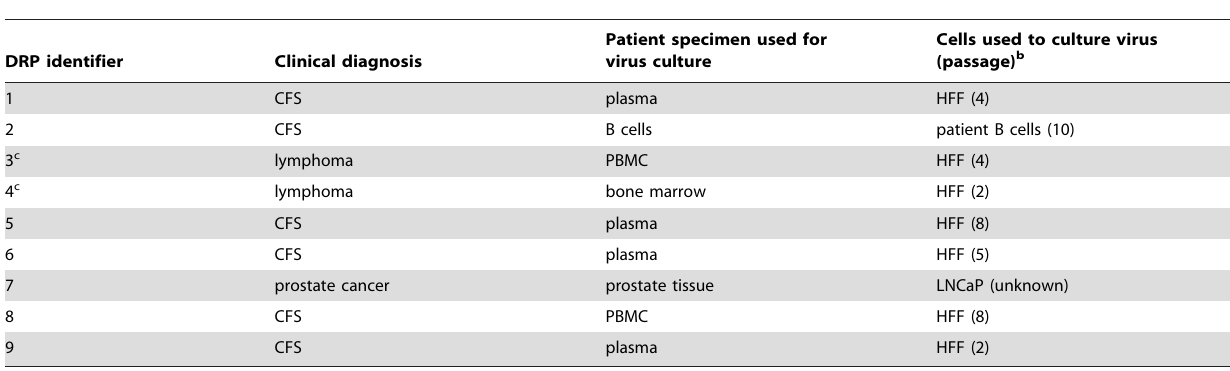
Table 2. Evaluation of cell culture supernatants from virus rescue experiments a .